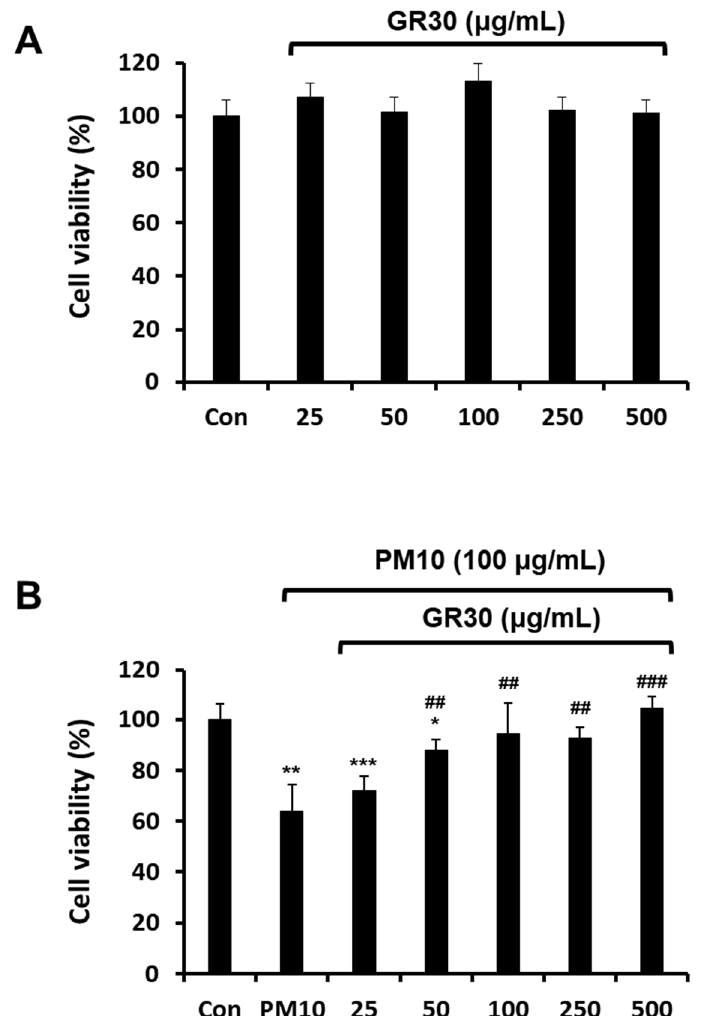
Figure 1. Effects of PM10 and GR30 on the viability of RBL-2H3 cells. ( A ) Cells were treated with GR30 (0–500 µ g/mL) for 48 h. Cell viability was measured by the trypan blue exclusion method. ( B ) The cells were pretreated with GR30 (25~500 µ g/mL) for 2 h, incubated with PM10 (100 µ g/mL) for 48 h and then the cell viability was measured. Each value was presented as the means ± SD ( n = 3). *, p < 0.05; **, p < 0.01; ***, p < 0.001, compared to the control cells (Con). ##, p < 0.01; ###, p < 0.001, compared to the PM10-treated cells